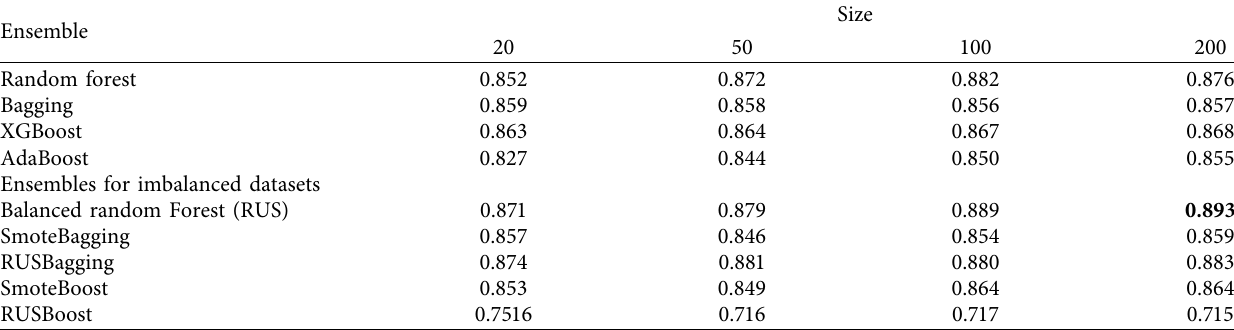
Bold numbers show the best performance. Table 6: The performance (AUPRC) of various ensembles of decision trees for different sizes of ensembles.